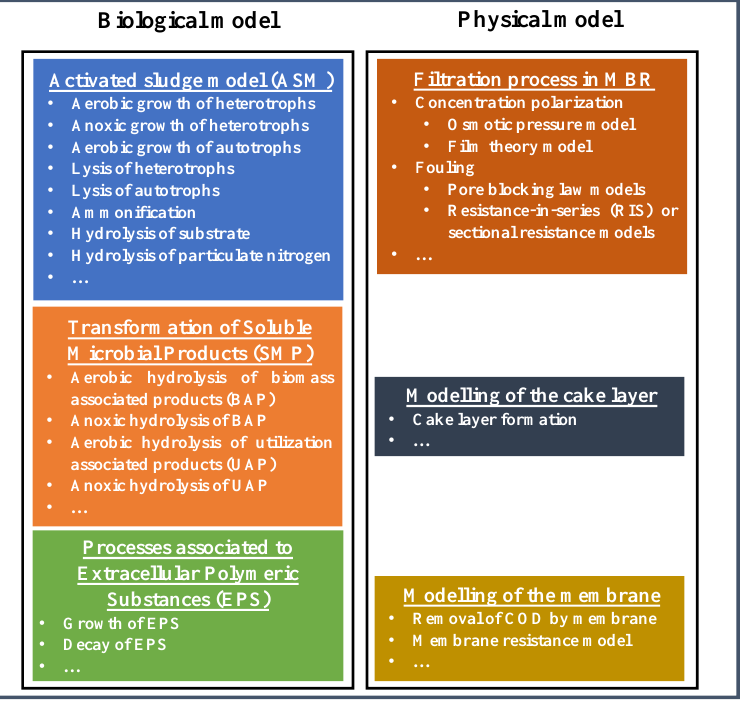
Figure 3. A conceptual framework for the mechanistic modelling of the biological processes inside the MBR (adapted from [56] and [49]).